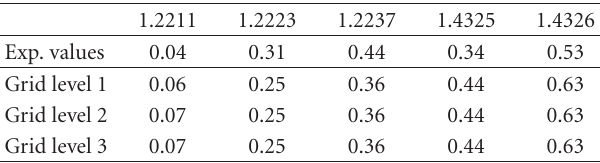
Table 4: Cross-section averaged void fraction obtained on the three grid